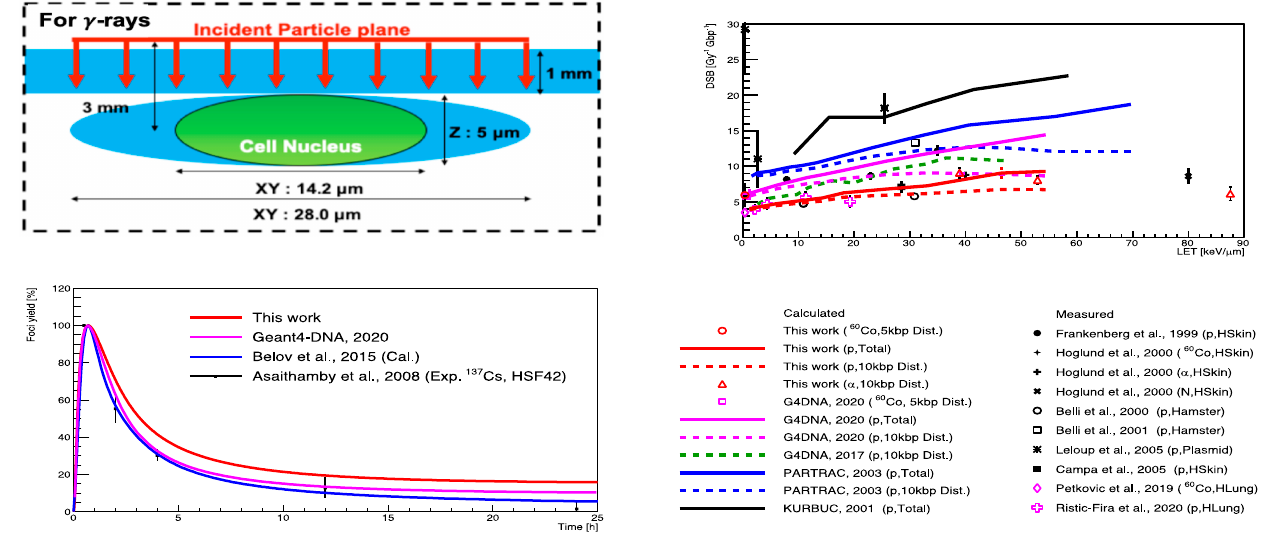
Figure 8. Left-top : The geometrical configuration for a human cell from Sakata et al. [127]. Right: Figure 8. ( Left-top ): The geometrical configuration for a human cell from Sakata et al. [128]. Right: the DSB yields as a function of LETtaken from Shin[106]. Left-bottom : the yield of γ -H2AX as a the DSB yields as a function of LETtaken from Shin [106]. ( Left-bottom ): the yield of γ -H2AX as a function of time after irradiation taken from [106]. function of time after irradiation taken from